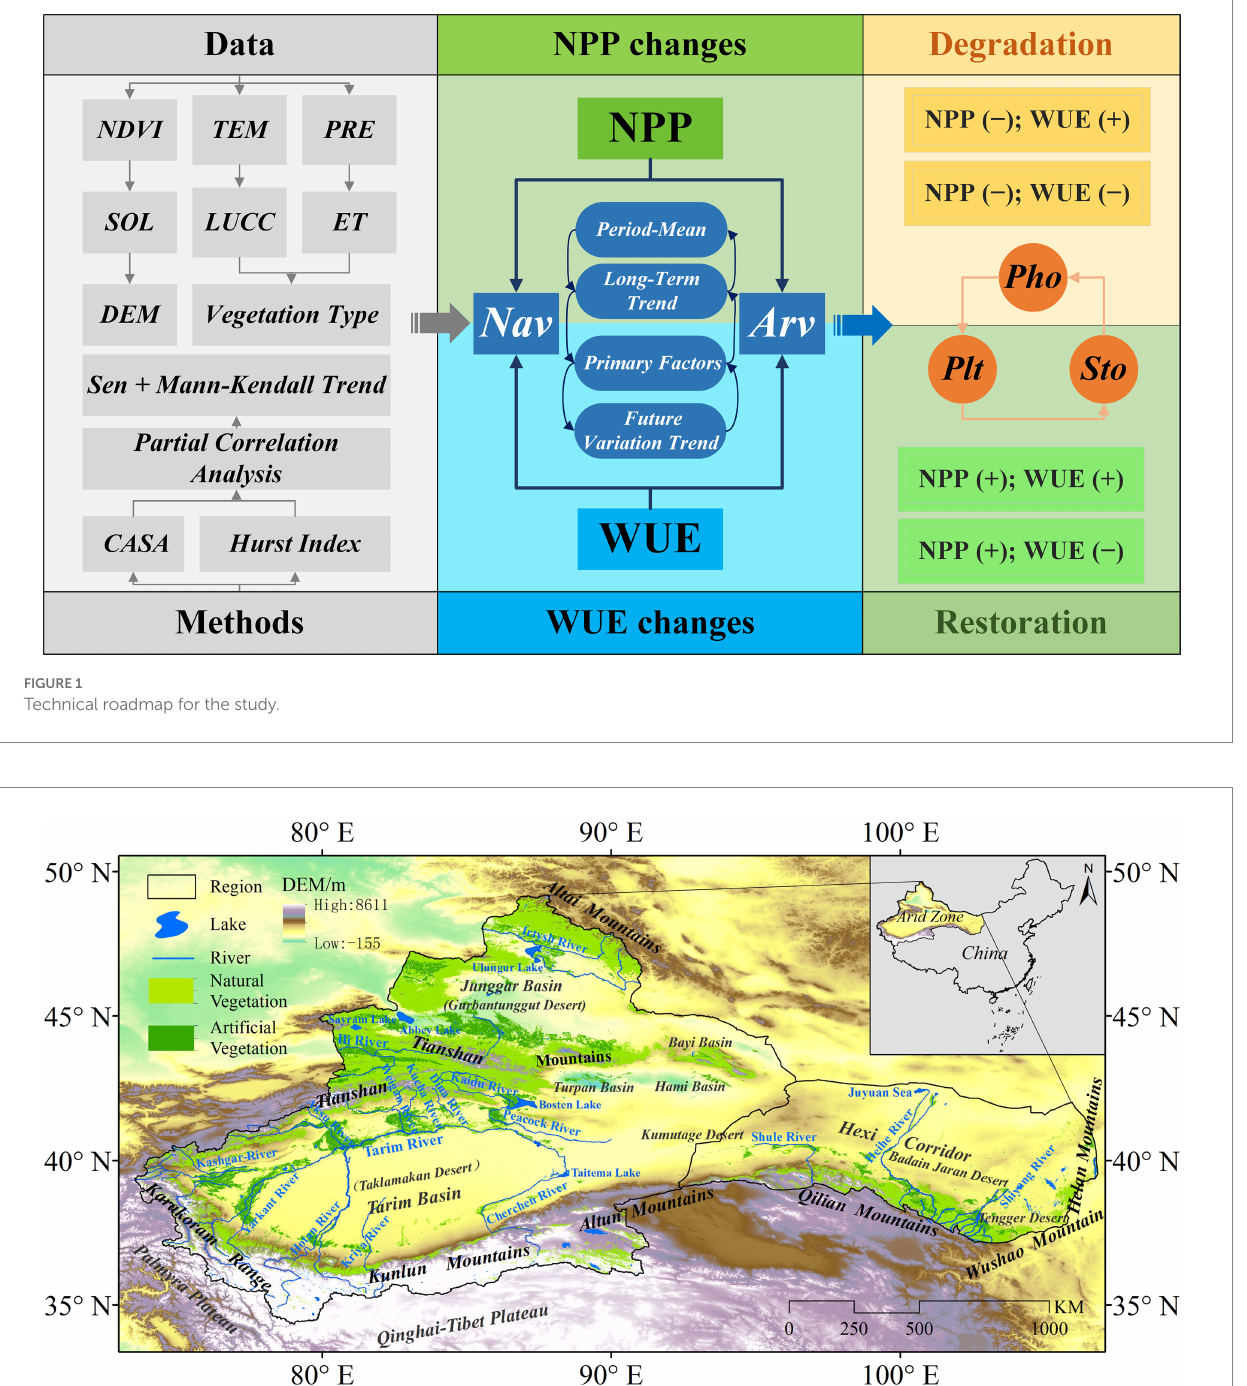
dataset for the global land surface that combines the WorldClim dataset with CRU Ts4.0 and JRA55 to create a high spatial resolution dataset covering a wider range of time records (Abatzoglou et al.,